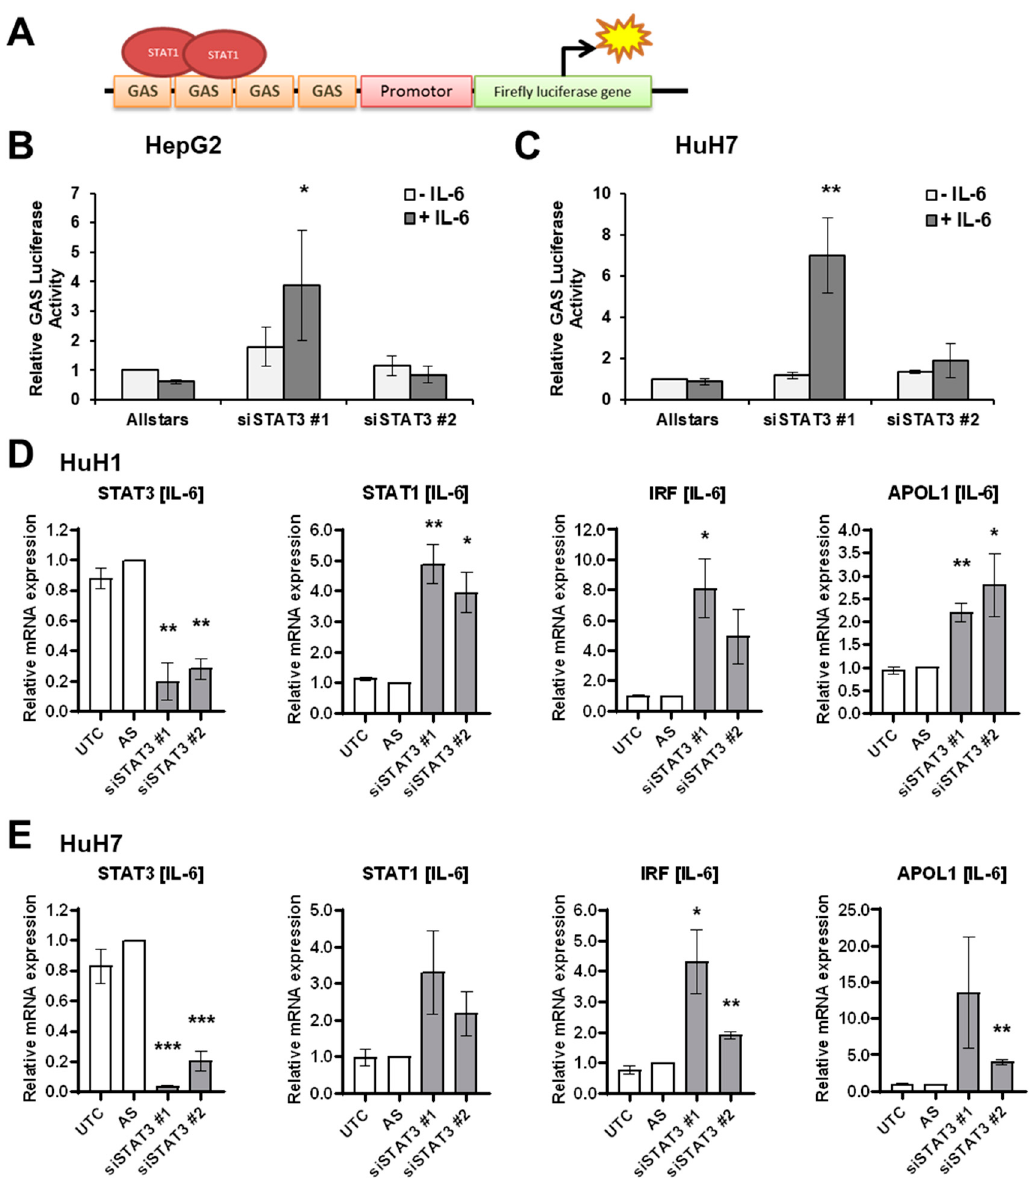
Figure 3. IL-6 induces STAT1 transcriptional activity upon STAT3 depletion. ( A ) To quantitatively measure STAT1 transcriptional activity, a luciferase reporter containing four interferon-gamma activated sites (GAS) was used. ( B , C ) Luciferase assay in ( B ) HepG2 and ( C ) HuH7 cells measuring endogenous STAT1 transcriptional activity using the GAS-element containing reporter co-transfected with Allstars (control), siSTAT3 #1, or siSTAT3 #2, in the presence or absence of 20 ng/mL IL-6 for 24 h, as indicated. Renilla luciferase was used as the internal transfection control and for normalization. Data were normalized to IL-6 unstimulated transfection control cells (mean ± SD). ( D , E ) Relative mRNA expression levels of STAT3 , STAT1 , and the STAT1 target genes IRF1 and APOL1 measured by semi-quantitative RT-PCR in ( D ) HuH1 and ( E ) HuH7 cells upon transfection with Allstars control siRNAs (AS), siSTAT3 #1, or STAT3 #2 in the presence of 20 ng/mL IL-6 for 24 h. N = 3. * p < 0.05, ** p < 0.01, *** p <